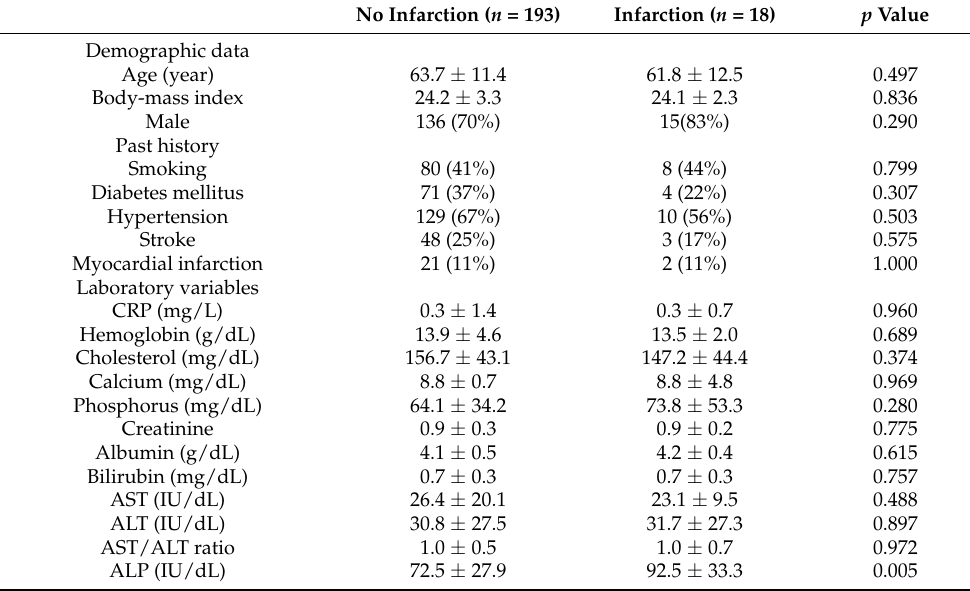
Table 3. Intergroup comparison of baseline characteristics based on the incidence of 30-day acute cerebral infarction. The values are presented as number (%) or mean ± standard deviation. Abbreviations: CRP: C-